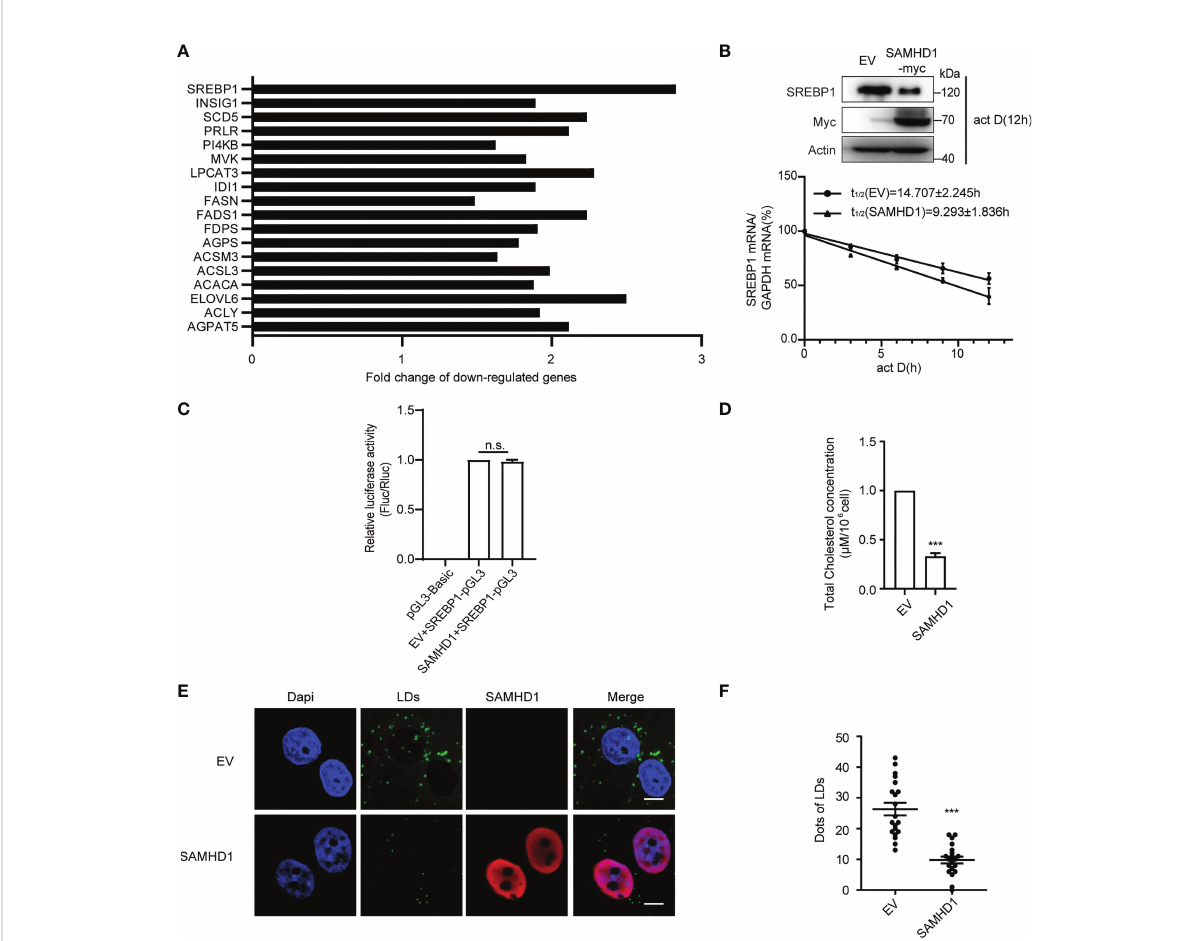
FIGURE 1 SAMHD1 negatively regulates fatty acid synthesis of cell. (A) Plasmid expressing SAMHD1 was transfected into Huh7.5.1 cells for 48 h, pcDNA4.0 was set as a control, and then cells were applied for quanti fi cation of genes associated with lipid metabolism by qRT-PCR analysis. The relative changes in gene expression were analyzed by using the 2 − DD CT method (Livak method). (B) mRNA decay assay was applied to measure the level of SREBP1 mRNA in SAMHD1-overexpressing cells at fi ve consecutive time points (0, 3, 6, 9, and 12 h) in the presence of 5 m g/ml actinomycin D Decay of SREPBP1 mRNA is depicted after normalization to GAPDH mRNA and mRNA half-lives are calculated (mean values ± SD; n = 3). The expression of endogenous SREBP1 and extrogenous SAMHD1 proteins at 12 h post-addition of actinomycin D was analyzed by Western blotting. (C) HEK392t cells were transfected with plasmid encoding SAMHD1-myc (or pcDNA4.0), pGL3-Basic-SREBP1 promoter, and phRL-TK for 48 h; promoter activities were indicated as a ratio of Fire fl y luciferase/Renilla luciferase. Data are shown as mean values ± SD ( n = 3). Values of the